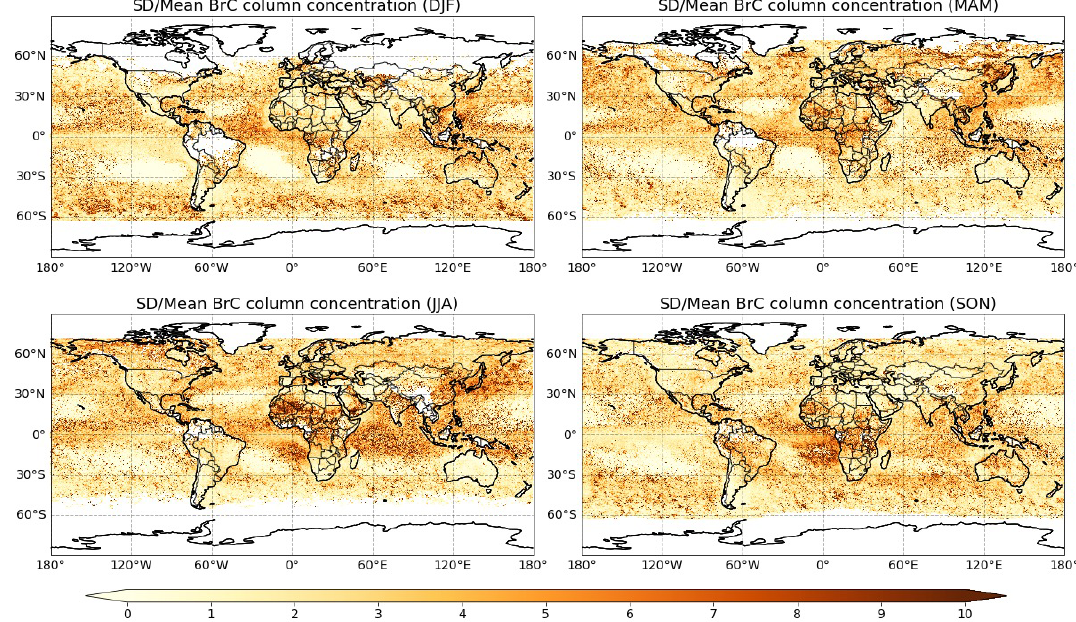
Figure 6. The standard deviation (SD)/mean for seasonal BrC column mass concentration in Fig. 5 derived from POLDER-3